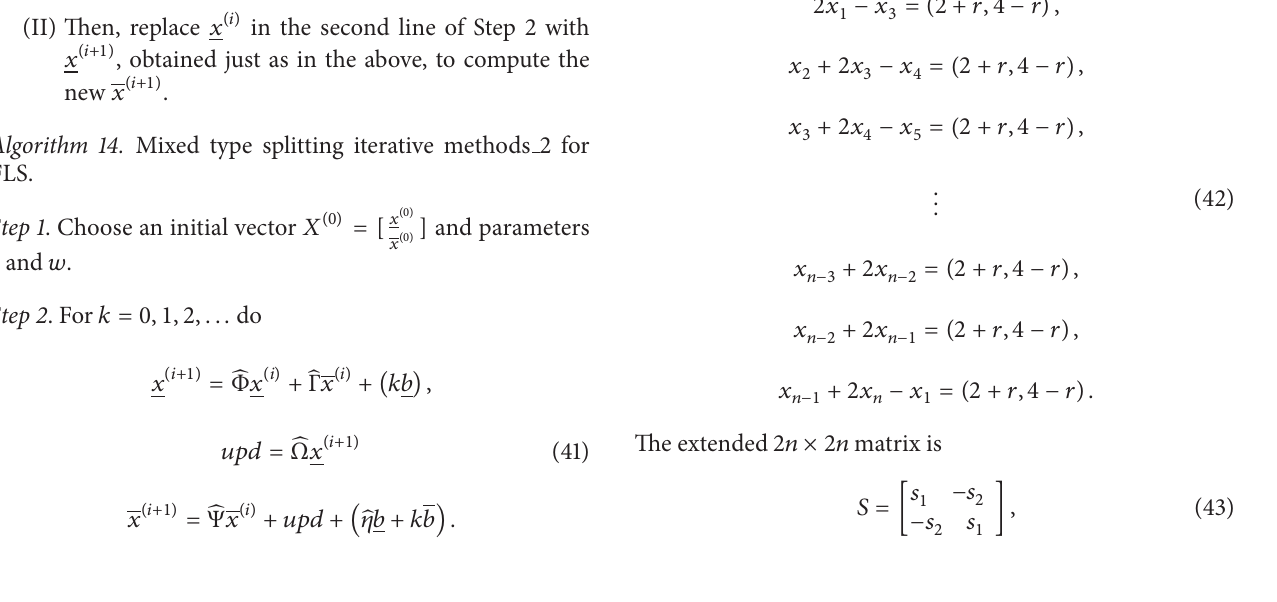
Algorithm 14. Mixed type splitting iterative methods 2 for